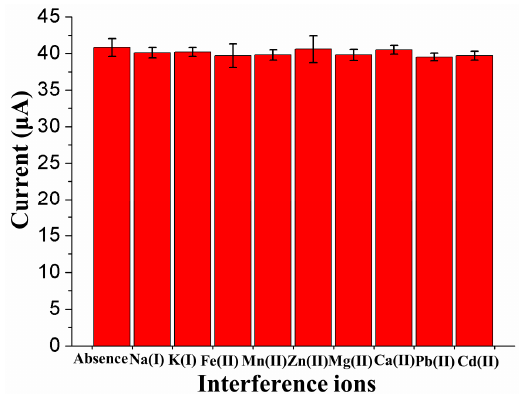
Figure 10. Interference study on the stripping peak currents of 15 µ g/L As(III) in the presence of 10-fold higher concentrations of different ions.